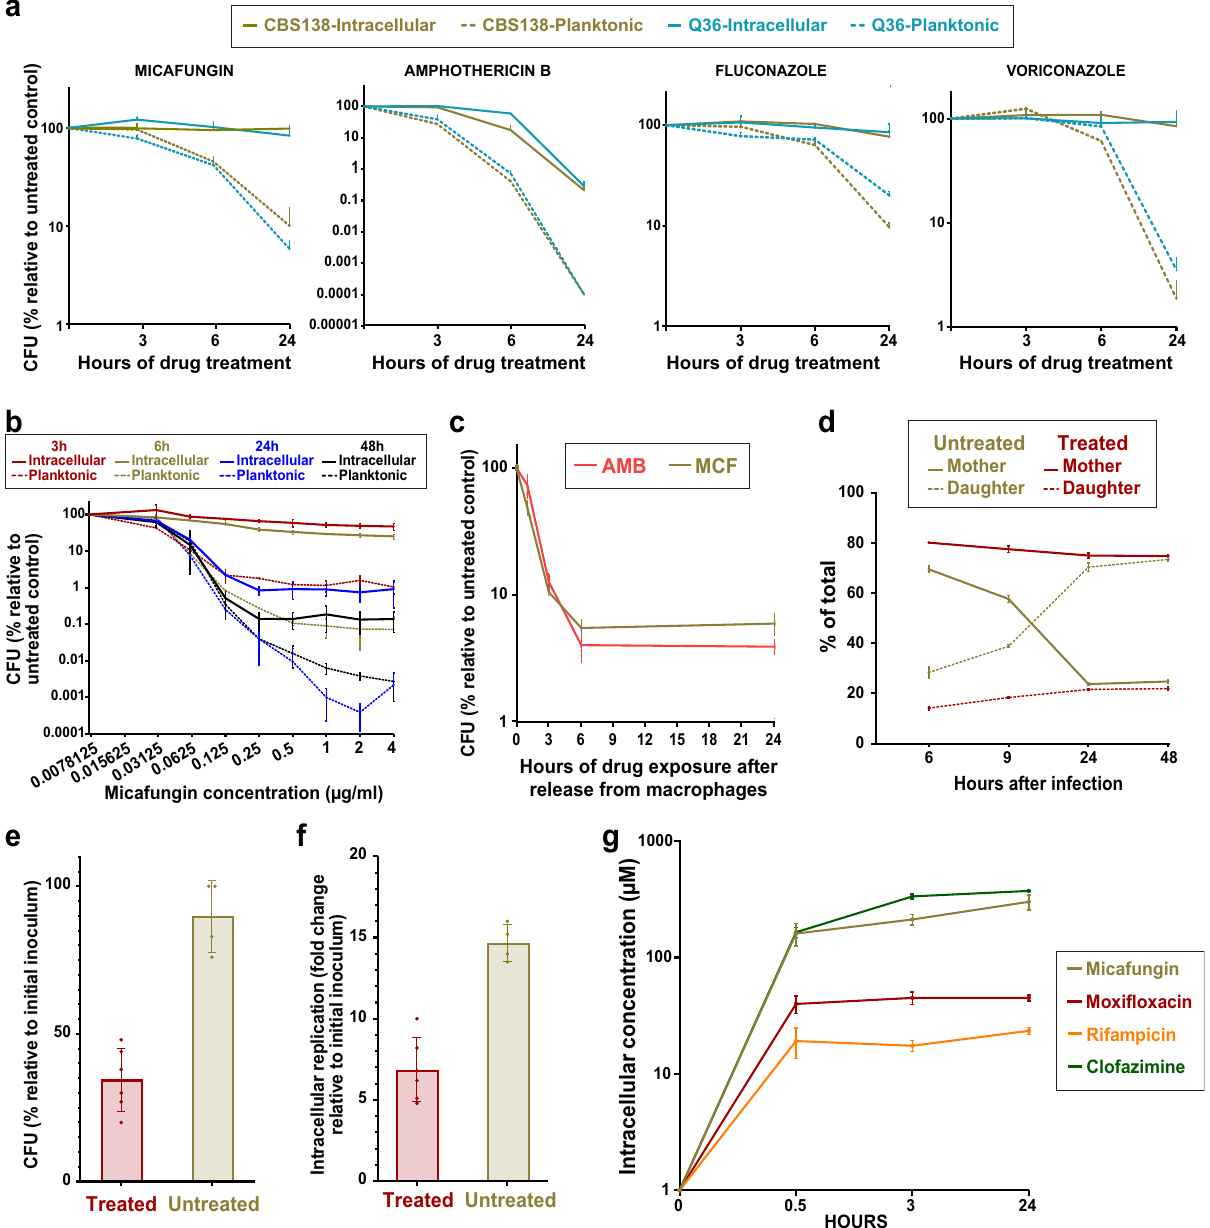
Fig. 1 | Intracellular C. glabrata (ICG) cells show multiple characteristics of persisters. a ICG are less sensitive to micafungin (0.03 µ g/ml), AMB (1 µ g/ml), fl u- conazole (8 µ g/ml), and voriconazole (0.06 µ g/ml) than their planktonic counter- parts. n =4 biological replicatesovertwo independent experiments. b ICG survival washigherthanthatofplanktoniccellsoverarangeofmicafunginconcentrations. n =4biologicalreplicatesovertwoindependentexperiments. c ICG exposed to8X MIC of micafungin (0.125 µ g/ml) or AMB (4 µ g/ml) show a biphasic killing pattern. n =3 biological replicates over 3 independent experiments. d Proportions of daughter(AF647ConA-positive)andmothercells(FITC-andAF-647ConA-positive) in micafungin-treated ICG remain stable over the course of treatment, indicating a lack of proliferation, whereas untreated ICG show a marked increase in the pro- portion of daughter cells. n =3 biological replicates in a single experiment. e Propidiumiodide(PI)-negative C.glabrata cellsreleasedfrommicafungin-treated